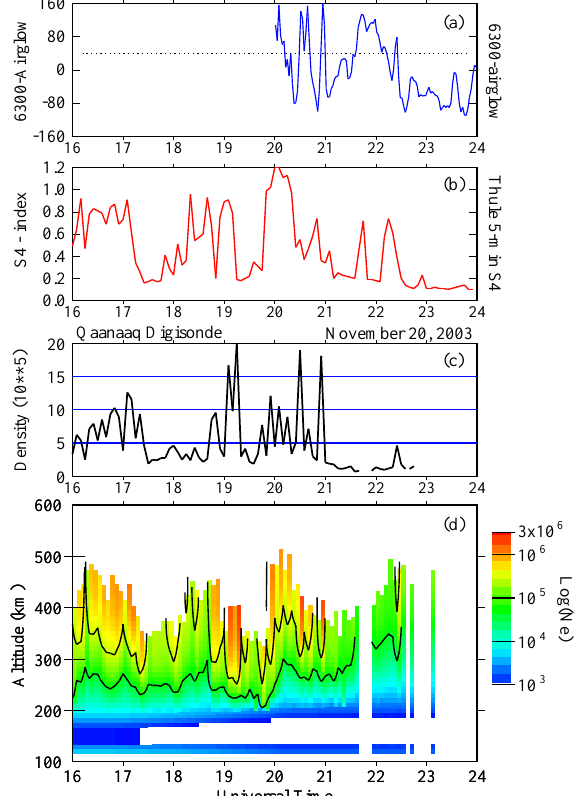
Figure 1. (a) Relative values of 630nm airglow emissions, (b) UHF S4 scintillation index, (c) peak density measured by the digisonde, (d) and color-coded bottomside density profiles. Numbers above panel (a) refer to the time when the airglow associated with patches 1, 3, and 4 passed overhead the Qaanaaq